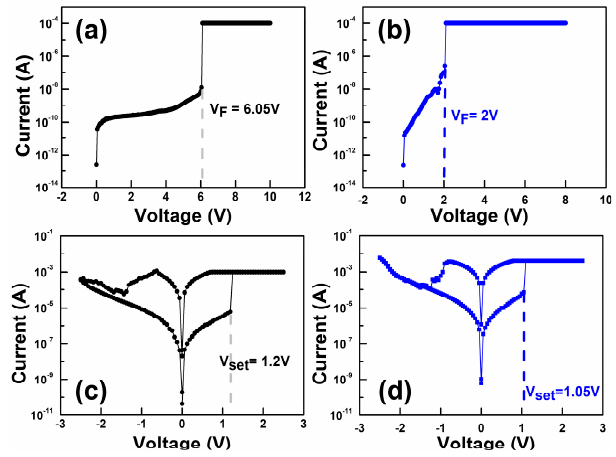
Figure 3. Forming curves of the ( a ) pristine and ( b ) Ar plasma-treated devices. Resistive switching characteristics of the ( c ) pristine and ( d ) Ar plasma-treated devices.